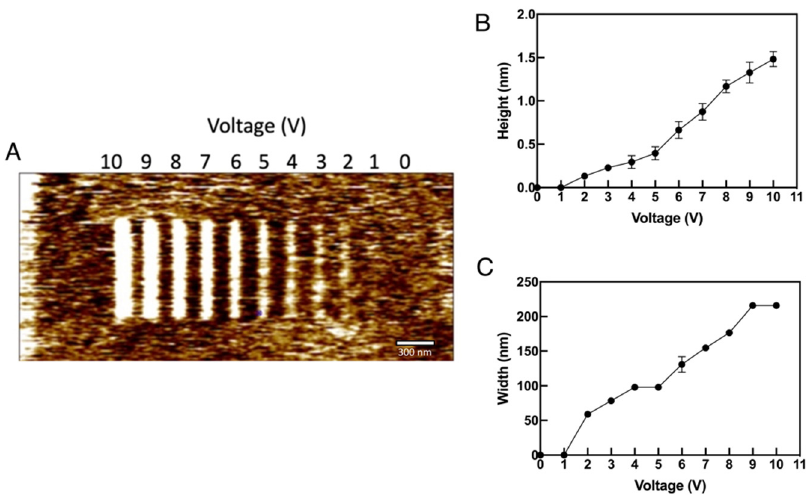
Figure 8. The LAO formation over HF treated silicon: ( A ) The formation of oxide deposits over HF treated silicon with different tip voltage ranging from 0 V to 10 V ( B ) The height vs. tip voltage characteristics and ( C ) The width vs. tip bias graph. F T = 0.1 μ N, V T = 1 μ m/s and RH ~26%.